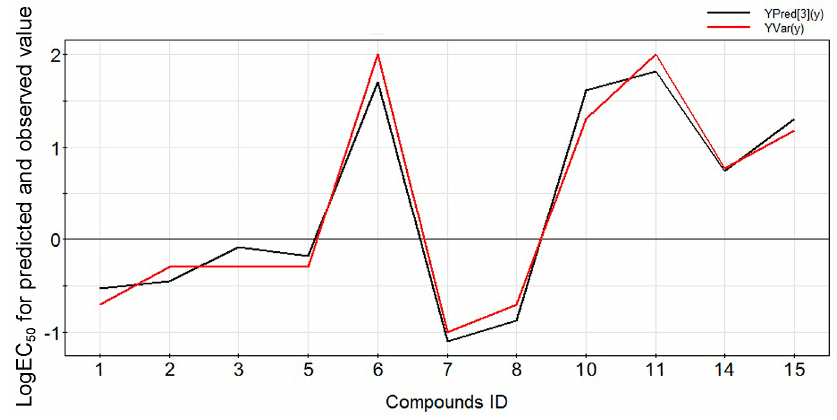
Figure 3. The curve fitting graph for the training dataset. YPred[3](y) and YVar(y) are respectively the predicted and observed values for the training set.